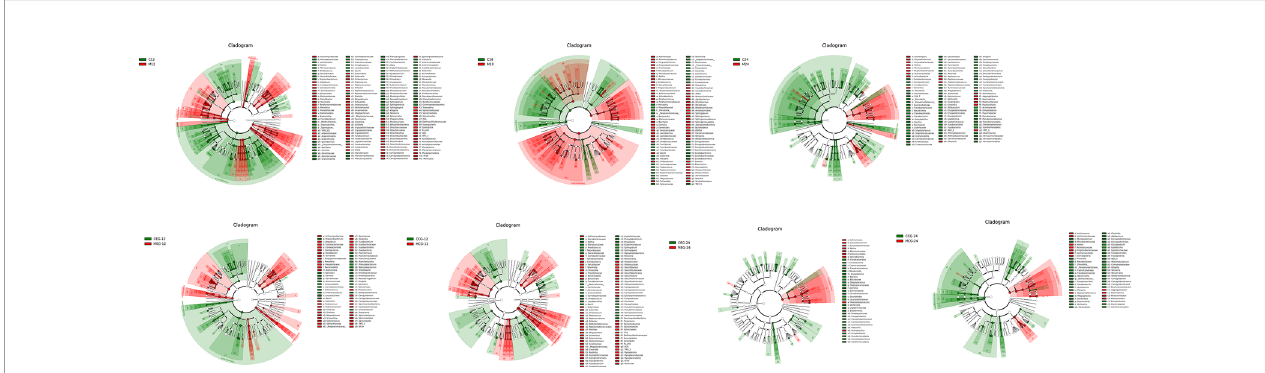
FIGURE 5 | The linear discriminant analysis effect size (LefSe). The colored nodes from the inner to outer circles represent the top abundant taxa from phylum to genus level. The white nodes represent taxa that are not signi fi cantly different between the groups, while nodes with other colors represent taxa that are signi fi cantly different between the